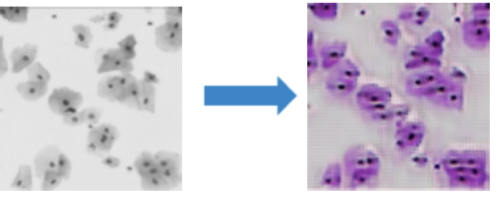
Figure 5. The style transfer GAN fails when images at two modalities contain different